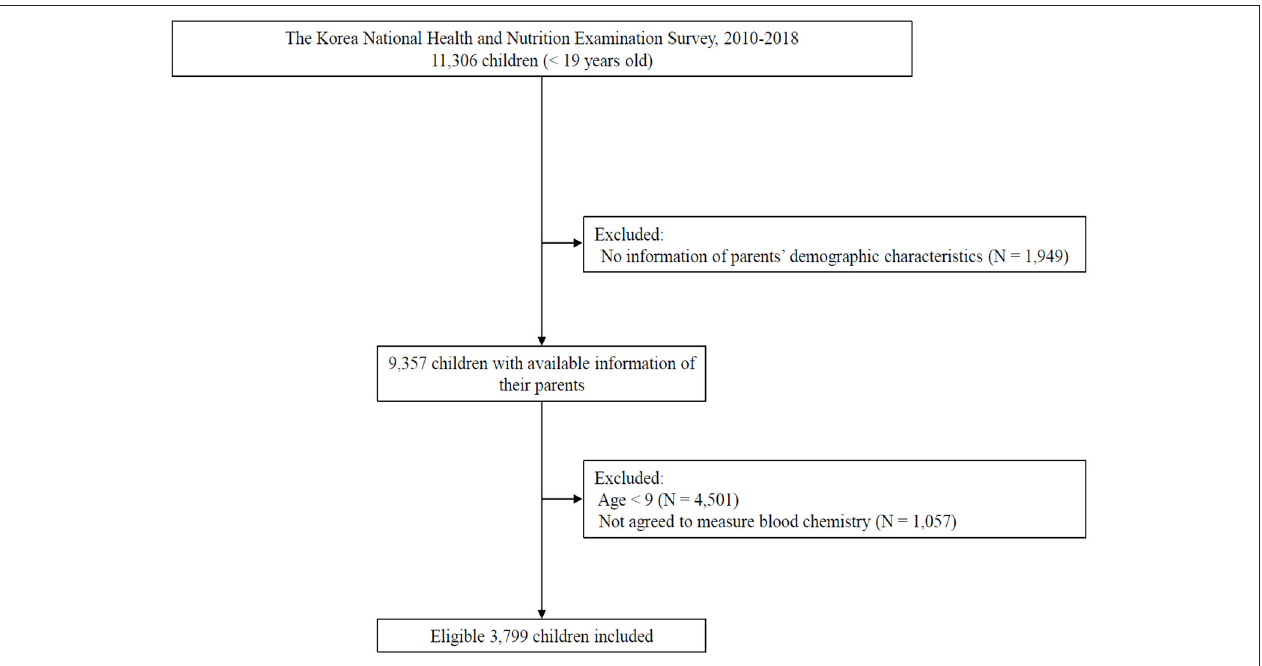
FIGURE 1 | Flow diagram of defining study subjects.